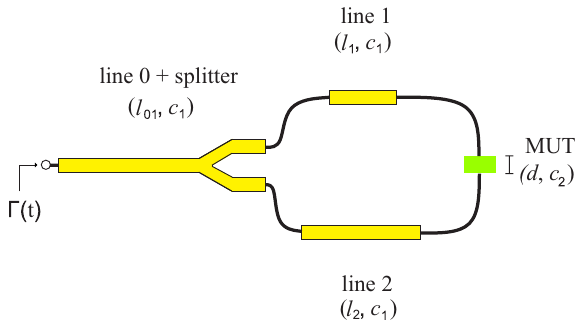
Figure 6. Schematical